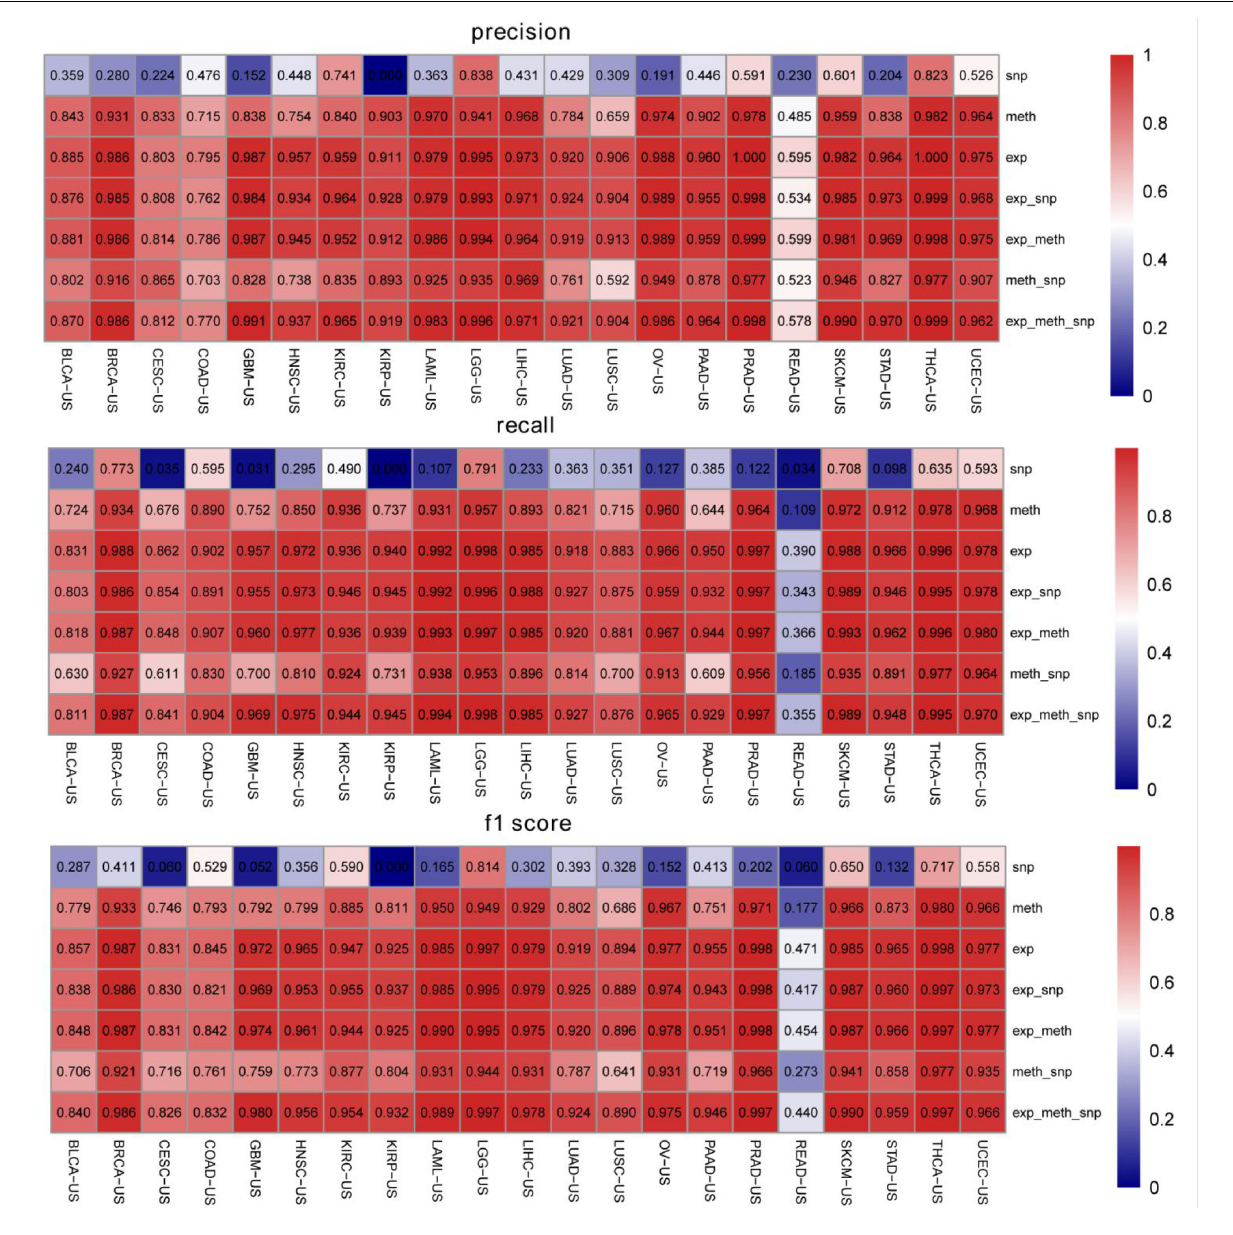
FIGURE 3 | The classification precisions, recall rates, and f1 scores for each biomarker combination on the 14 top-ranked genes for each cancer type. exp represents gene expression profiling, meth represents DNA methylation, and snp represents somatic